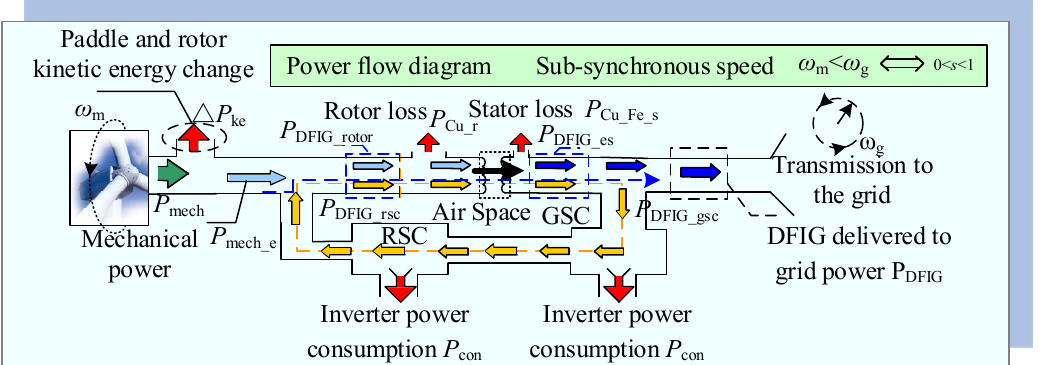
Figure 2. The power flow relationship of DFIG in a sub-synchronous operation.